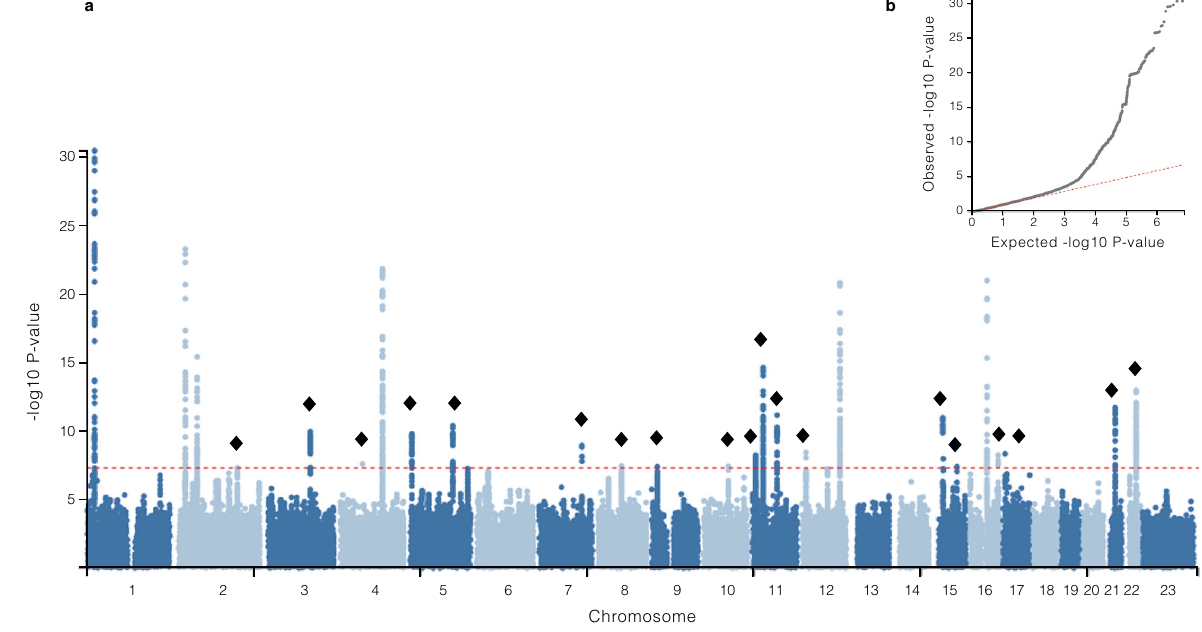
Fig. 1 Manhattan plot showing genome-wide signi fi cant loci associated with pelvic organ prolapse and QQplot. a Manhattan plot for GWAS meta- analysis for pelvic organ prolapse The novel candidates are highlighted as a black diamond. The y axis represents − log 10 ( P- values) for association of variants with POP, from mixed logistic regression analysis of cohorts (adjusted by year of birth and 10 principal components). The horizontal dashed line represents the threshold for genome-wide signi fi cance ( P < 5 × 10 − 8 ). b QQ plot. The panel displays a QQ plot, which show the − log 10 ( P- values) based on a two-sided Z- tests for all SNPs. The dotted line represents the expected − log 10 ( P -values) under the null